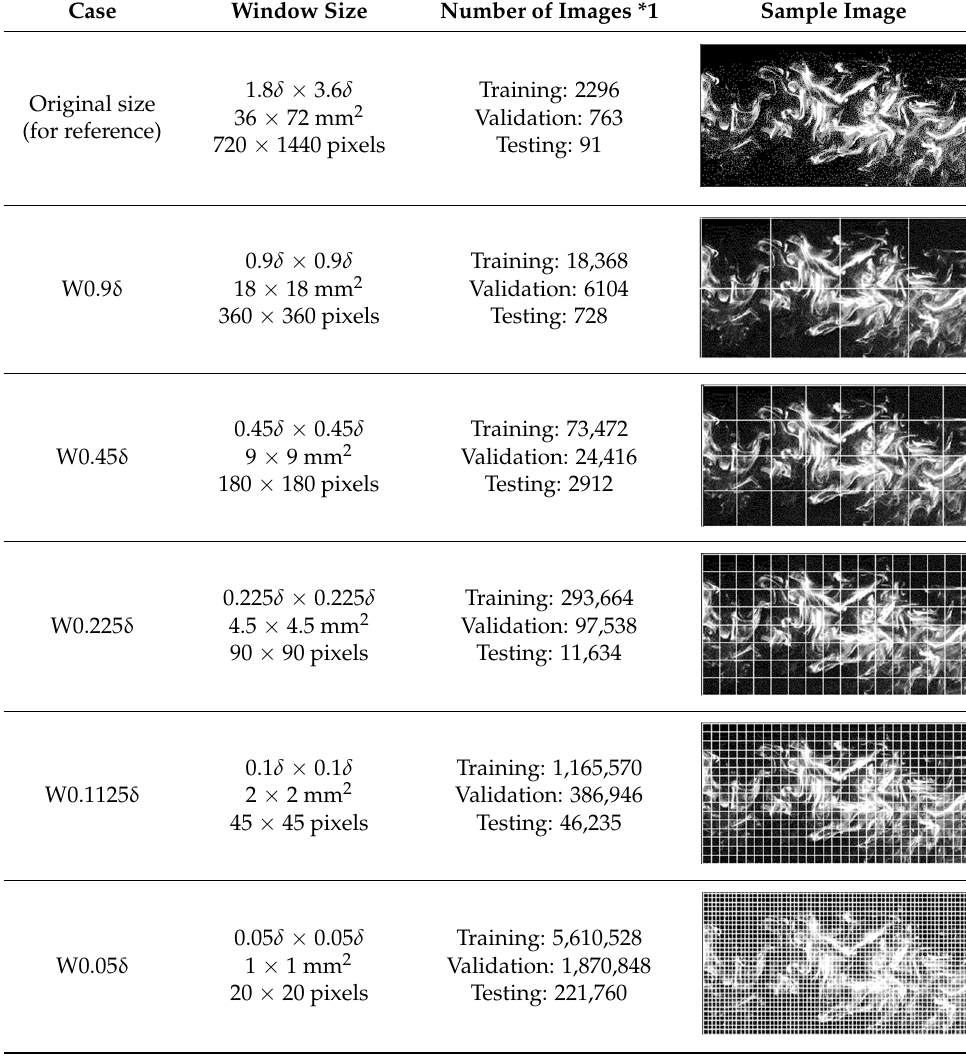
Table 1. Image size and number of images.